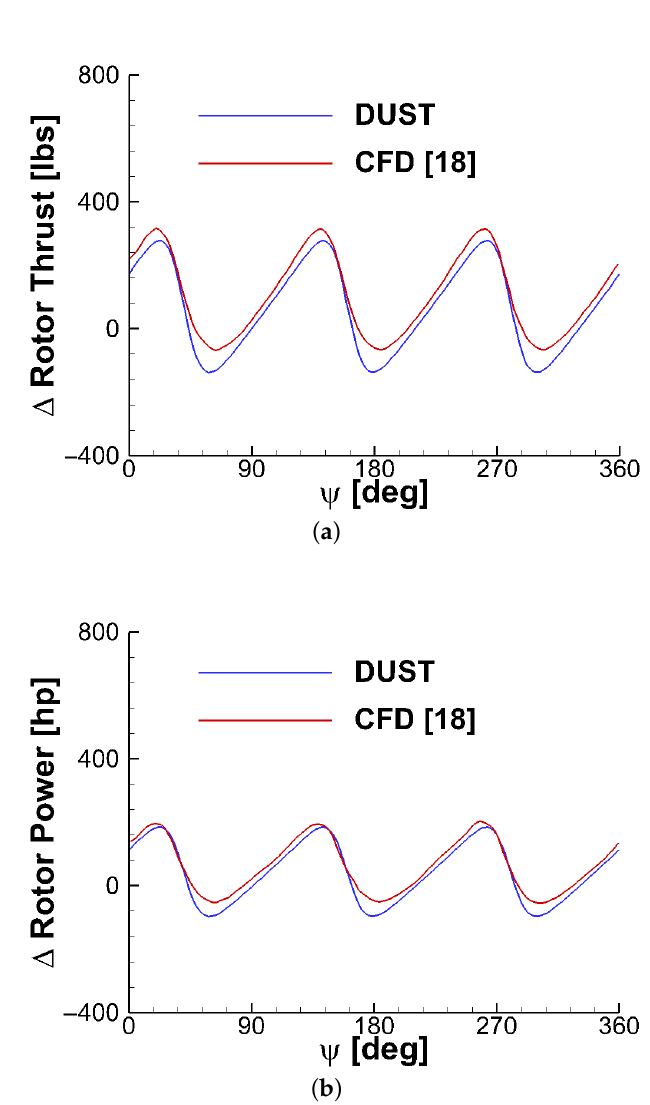
Figure 8. Comparison of the time history of the proprotor global thrust and power variations due to the wing installation, α = 5 ◦ , V ∞ = 220 kts, Ω = 517